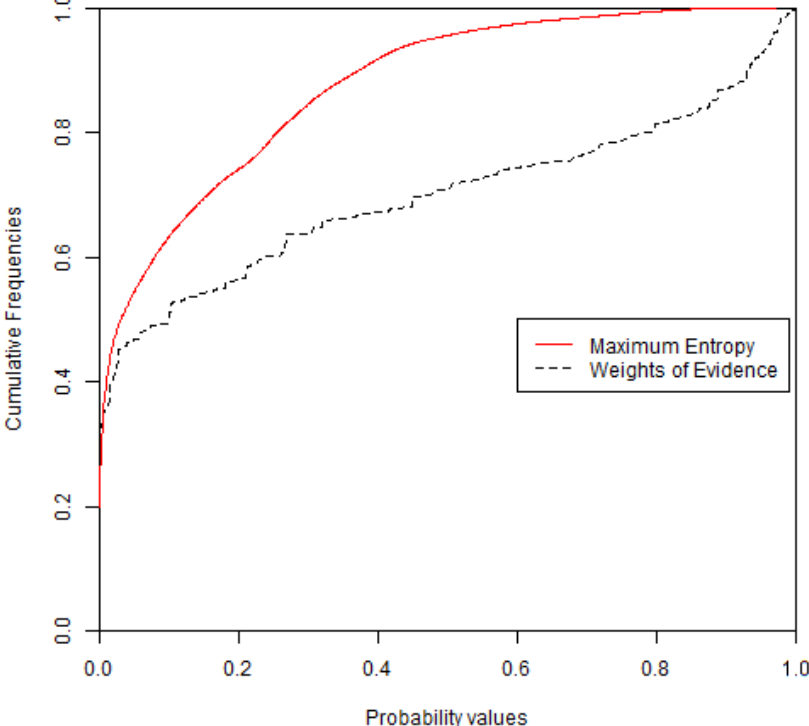
Figure 8. Cumulative distribution functions (CDFs) for the probability maps from WofE and MaxEnt. The vertical axis is the proportion of the candidate region that has a probability values less than or equal to the value on the horizontal